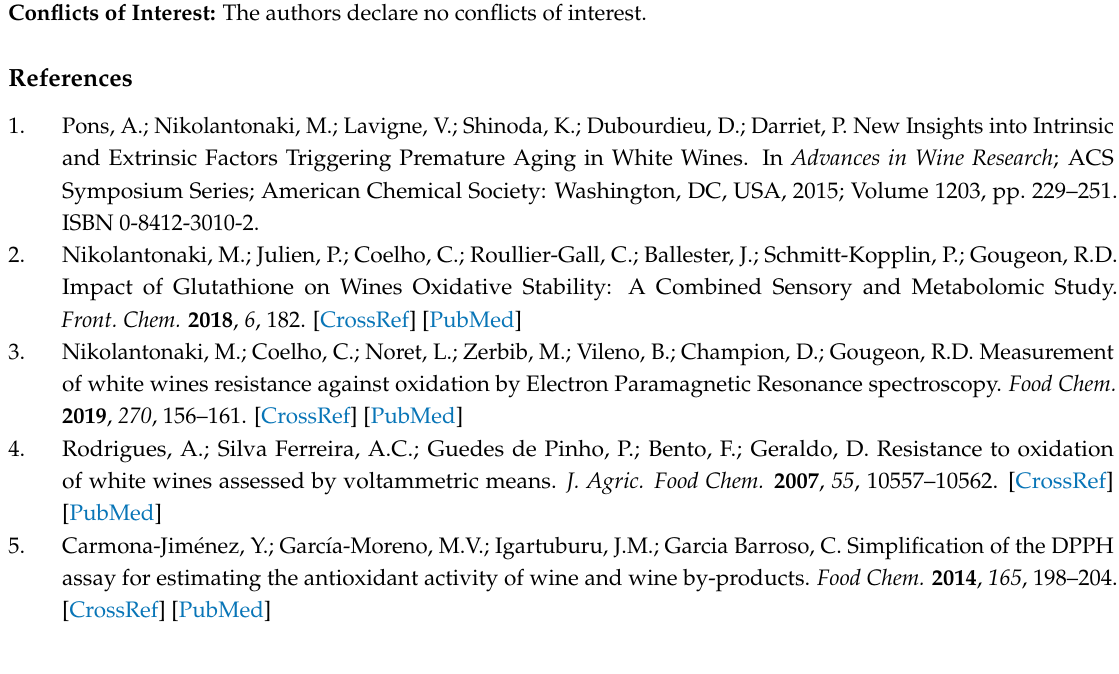
Supplementary Materials: The following are available online. Figure S1 UV-Vis absorbance spectra of DPPH in methanol and methanol-buffer, Figure S2 DPPH measurements for two vintages (1999 and 2012) in